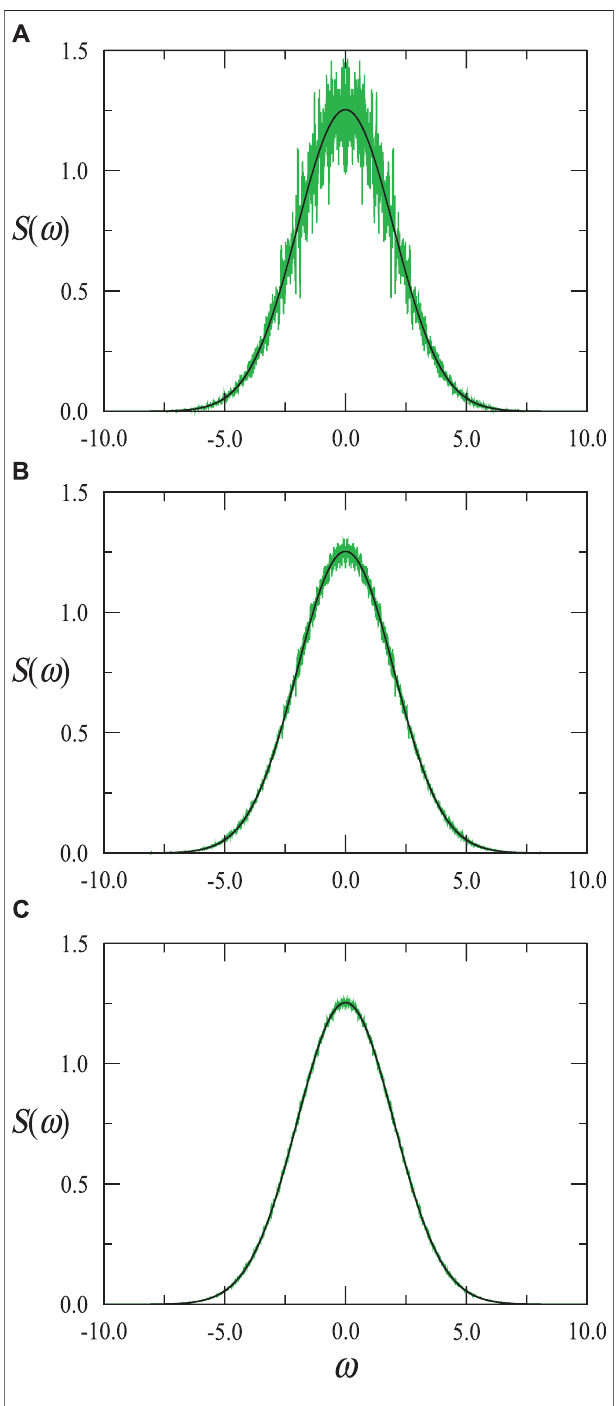
FIGURE 2 | Spectral density for the TI model ( B (cid:2) 1 and J 2 (cid:2) 0) and different chain sizes. The plots are the time Fourier transforms of the curves in Figure 1 . The curves for fi nite chains oscillate around the exact Gaussian result of the in fi nite chain. [From Ref. [17]]